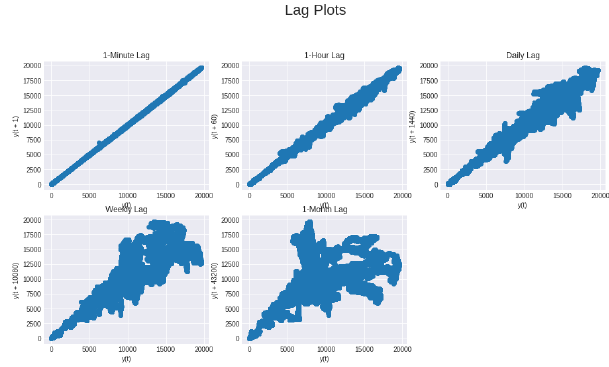
Figure 5. Lag Plots